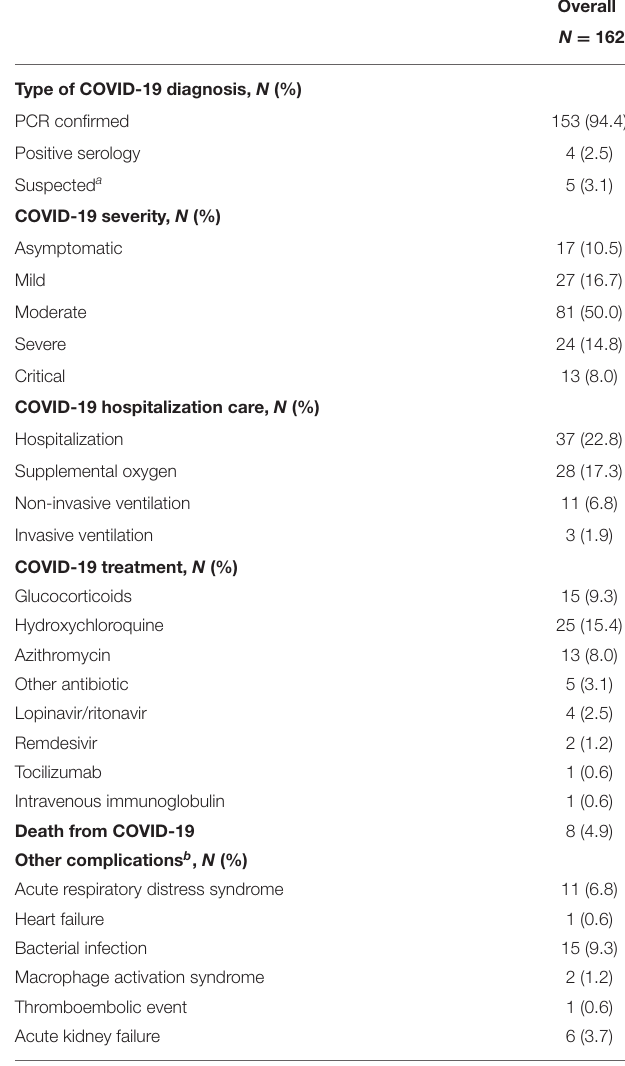
TABLE 2 | Multivariate binary logistic regression model for prediction of COVID-19 infection.